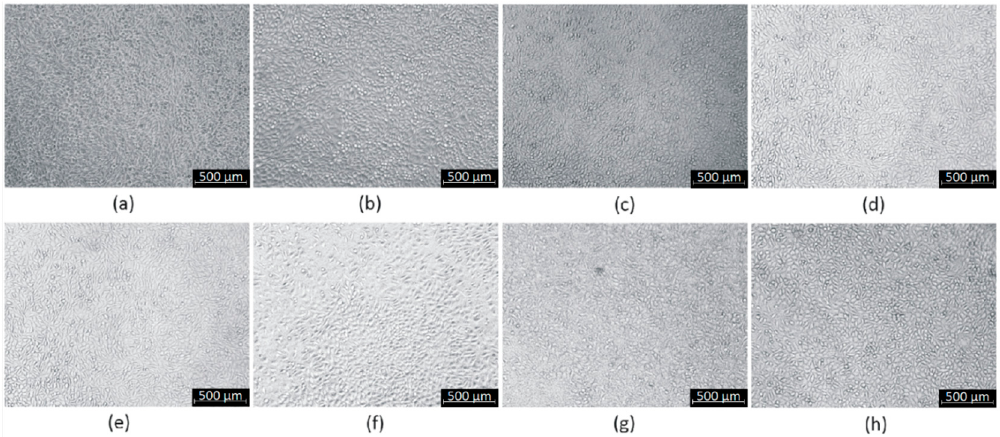
Figure 11. Cytotoxicity study carried out on L929 mouse fibroblasts ( a )—CS-PLA-30; ( b )—CS-PLA-35; ( c )—CS-PLA-30-Fe 3 O 4 ; ( d )—CS-PLA-35-Fe 3 O 4 ; ( e )—CS-PLA-30-ZnO; ( f )—CS-PLA-35-ZnO; ( g )—CS-PLA-30-Au; ( h )—CS-PLA-35-Au.